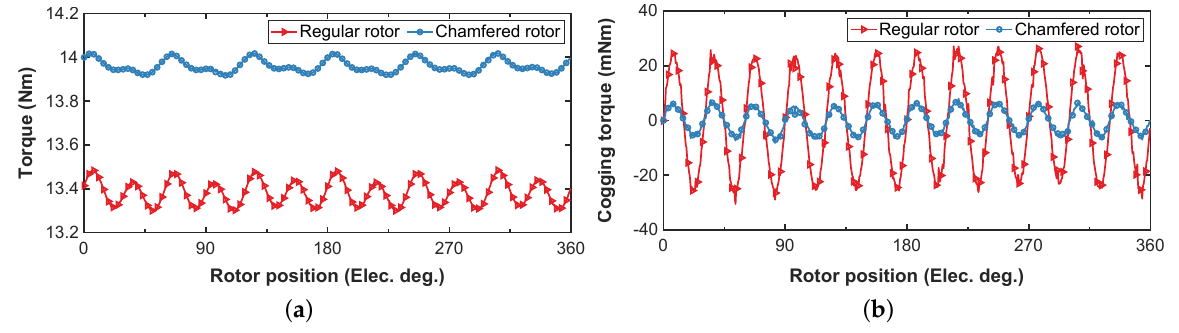
Rotor position (Elec. deg.)